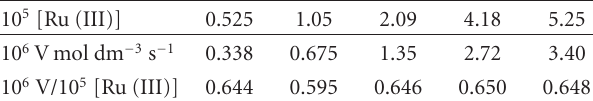
Table 2: E ff ect of variation of [Ru (III)]. 10 3 [NBS] = 5.00